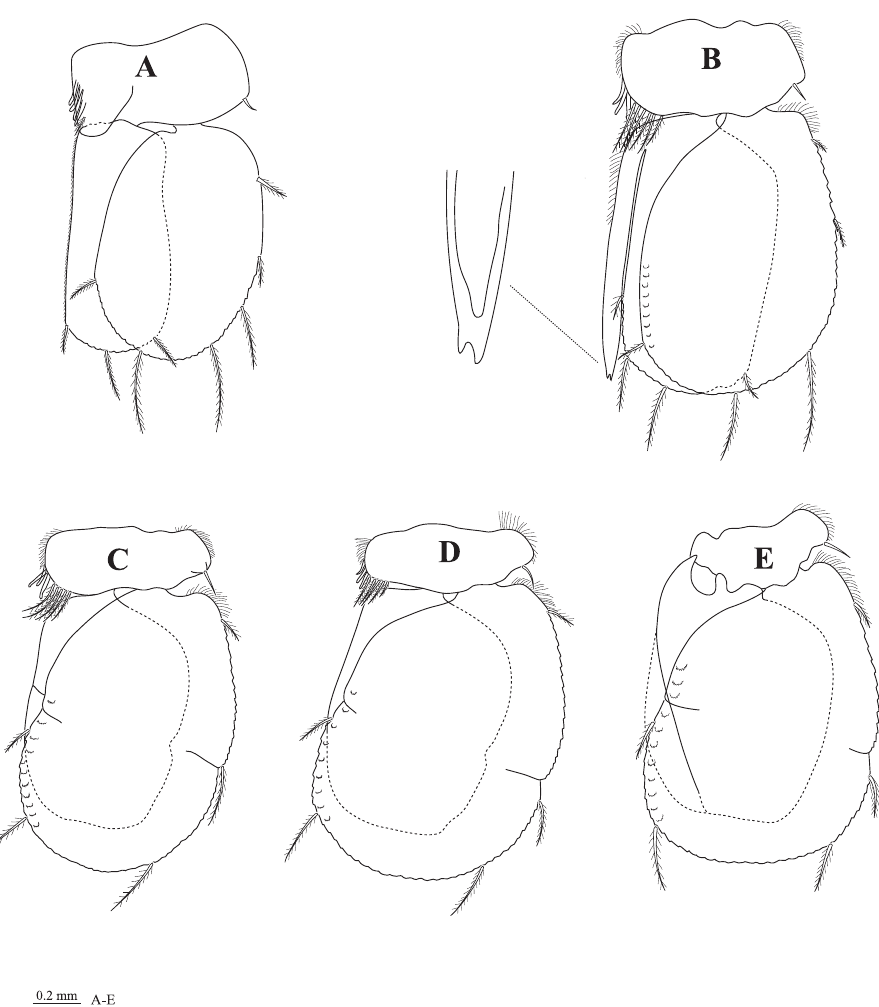
Figure 5. Cirolana songkhla sp. n., male paratype (PSUZC-CR0281-2) (11.2 mm) A–e pleopods 1–5